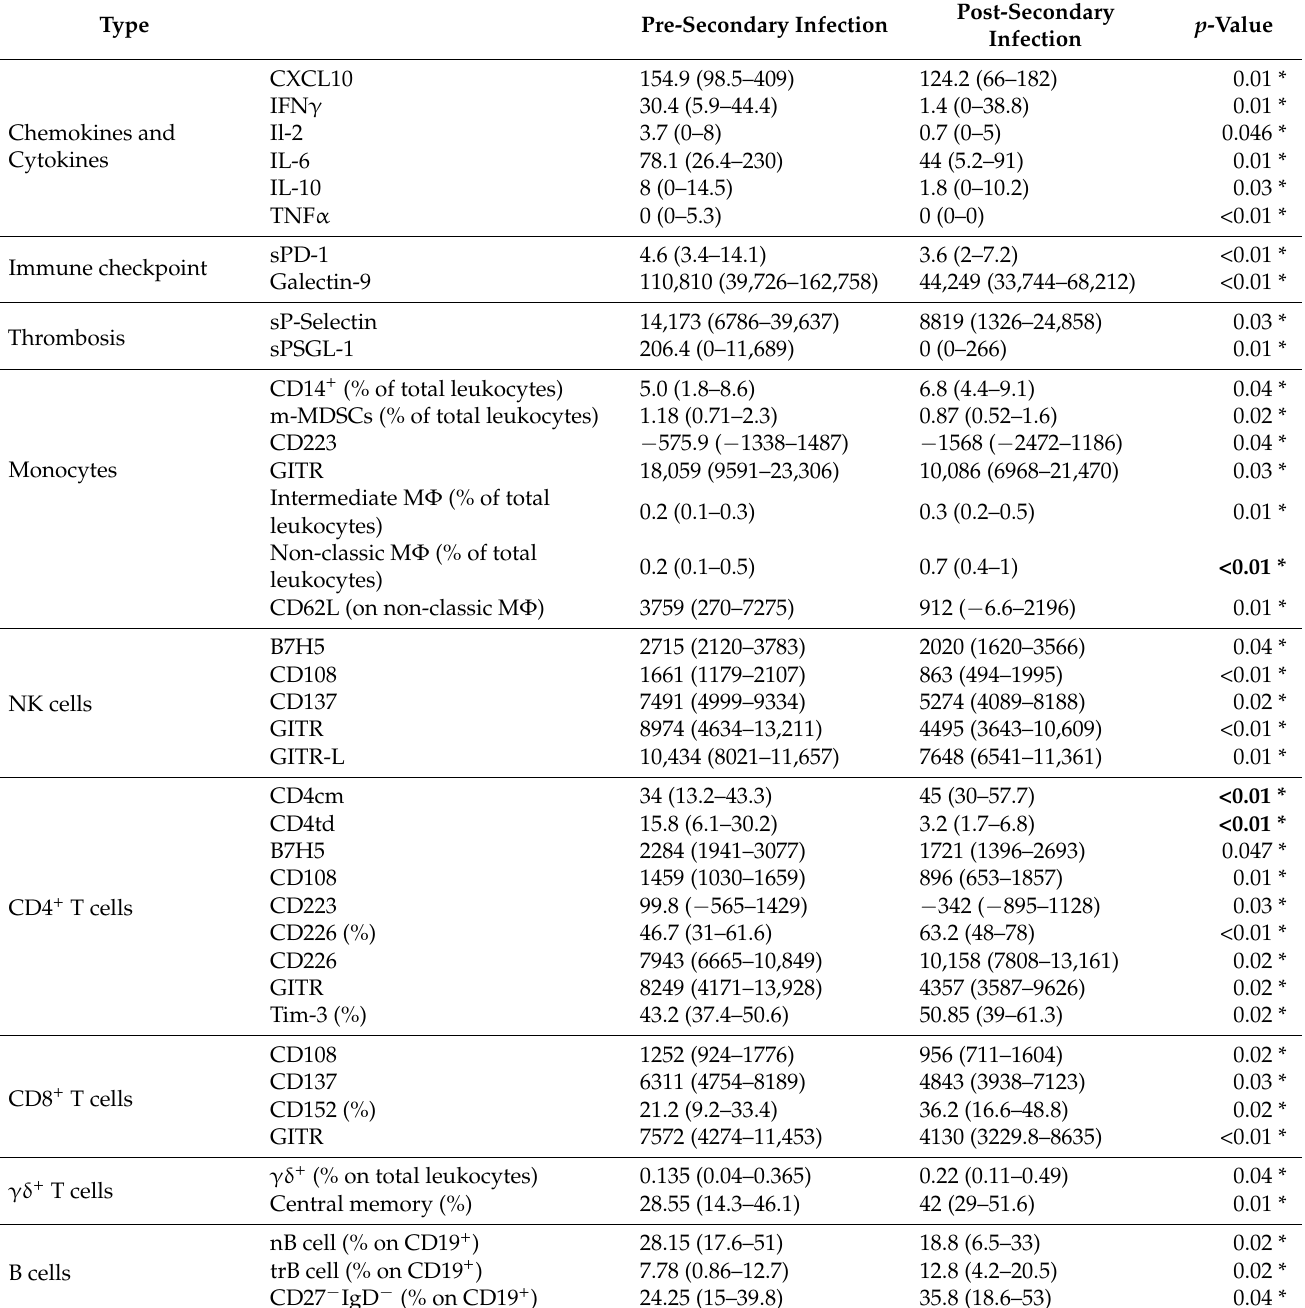
Table 3. Immune parameters and markers previous and after secondary infection in COVID-19